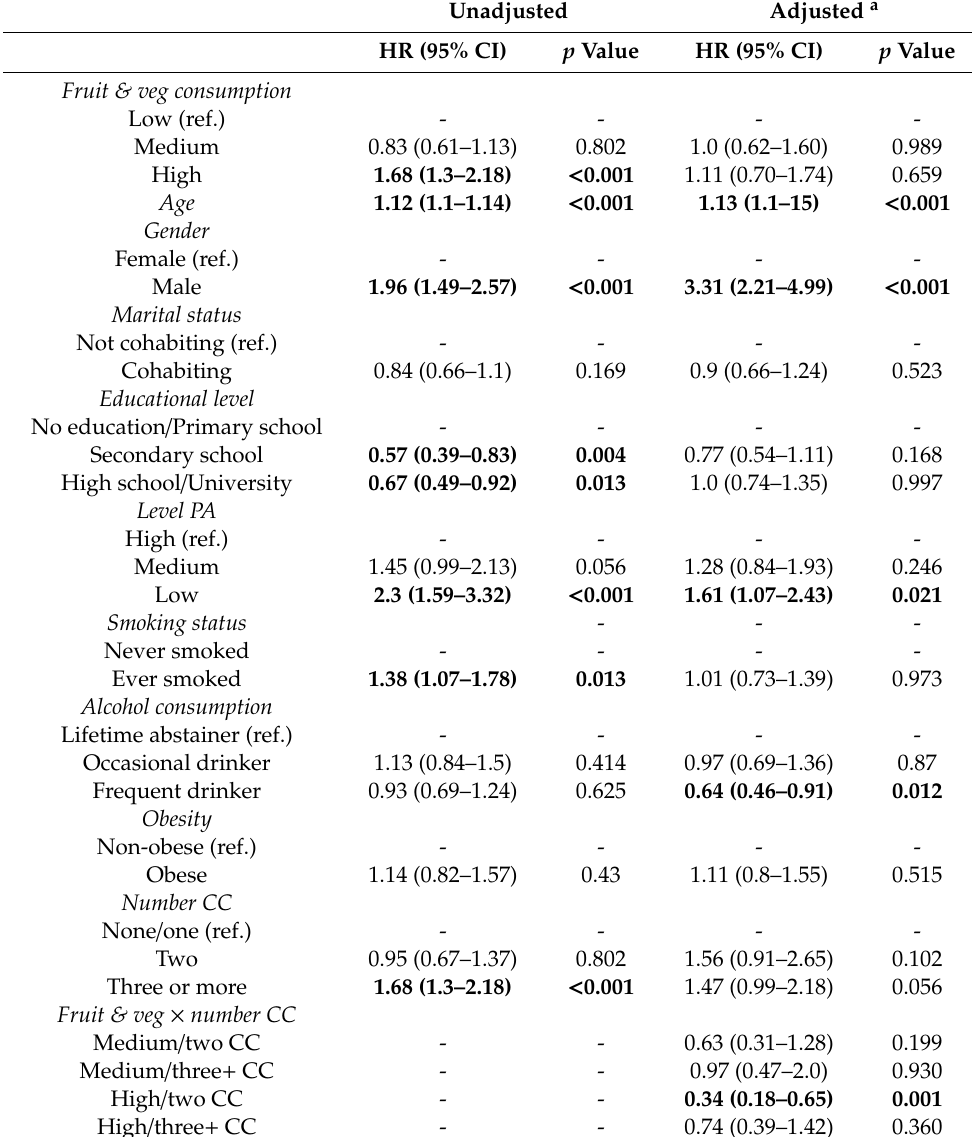
Table 2. Hazard ratios, Confidence intervals and p values for the unadjusted and adjusted Cox proportional hazards models ( n = 1699).